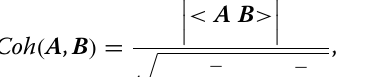
is defined as follows: